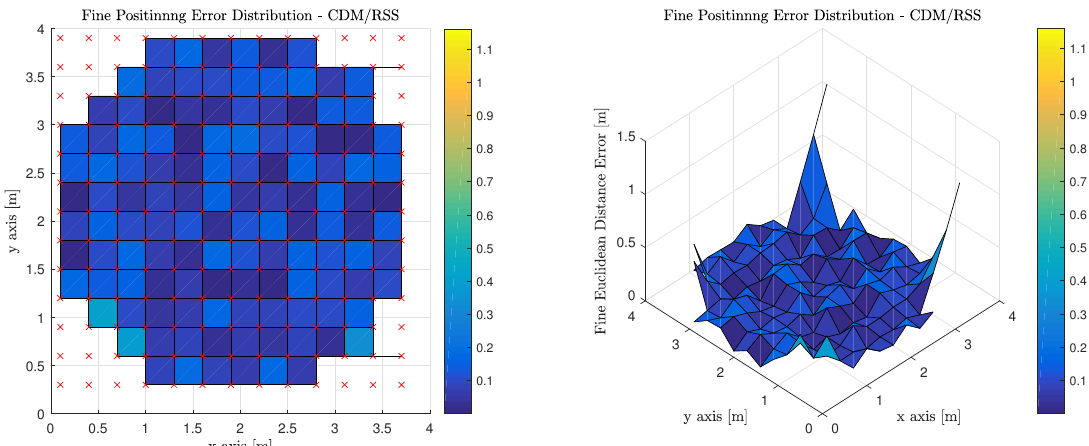
Figure 17. Fine Phase Positioning Performance in Candidate Room using Received Signal Strength Measurement, Least Squares Triangulation Positioning Algorithm and Code Division Multiplexing.